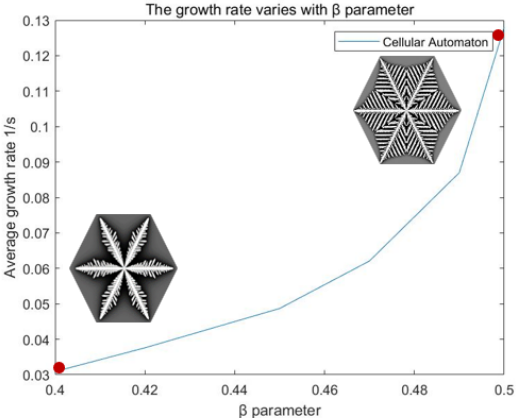
Figure 16. The growth rate varies with the β parameter by CA.